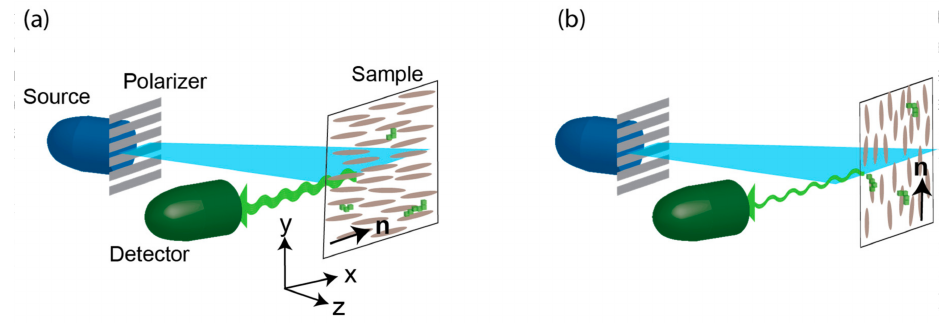
Figure 3. Schematic representation of the geometries employed to obtain X-Y anisotropic emission depicting the liquid crystal alignment and polarization of the incident light whose direction is decided by the polarizer oriented horizontally. The arrangement is referred to as X when the director is parallel to this horizontal (panel a ), as Y when the director is perpendicular but still in the substrate plane (panel b ), and as Z when the director becomes out of plane. In the sample pane, the ellipses represent LC molecules, and the blocks QC assembly.